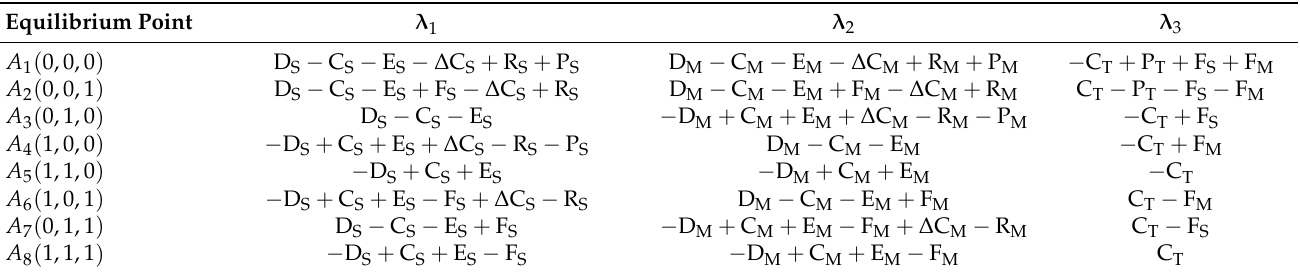
Table 2. Characteristic values of each equilibrium